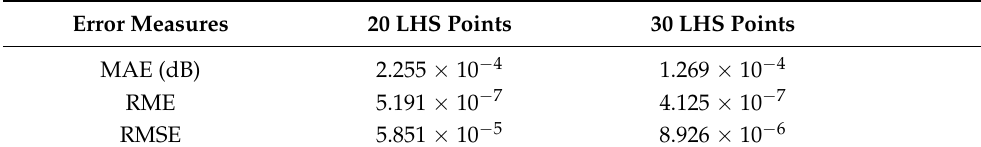
Table 2. Kriging accuracy results.